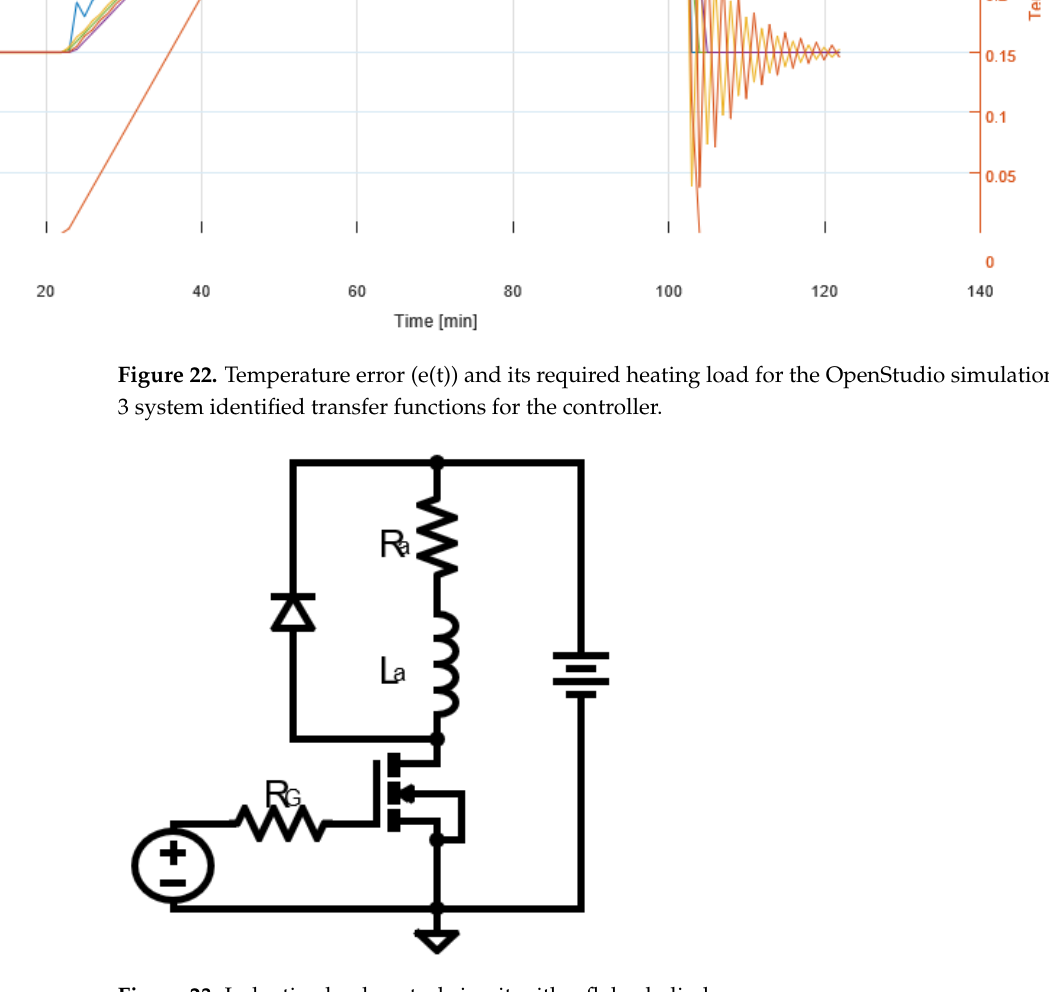
Figure 23. Inductive load control circuit with a flyback diode.